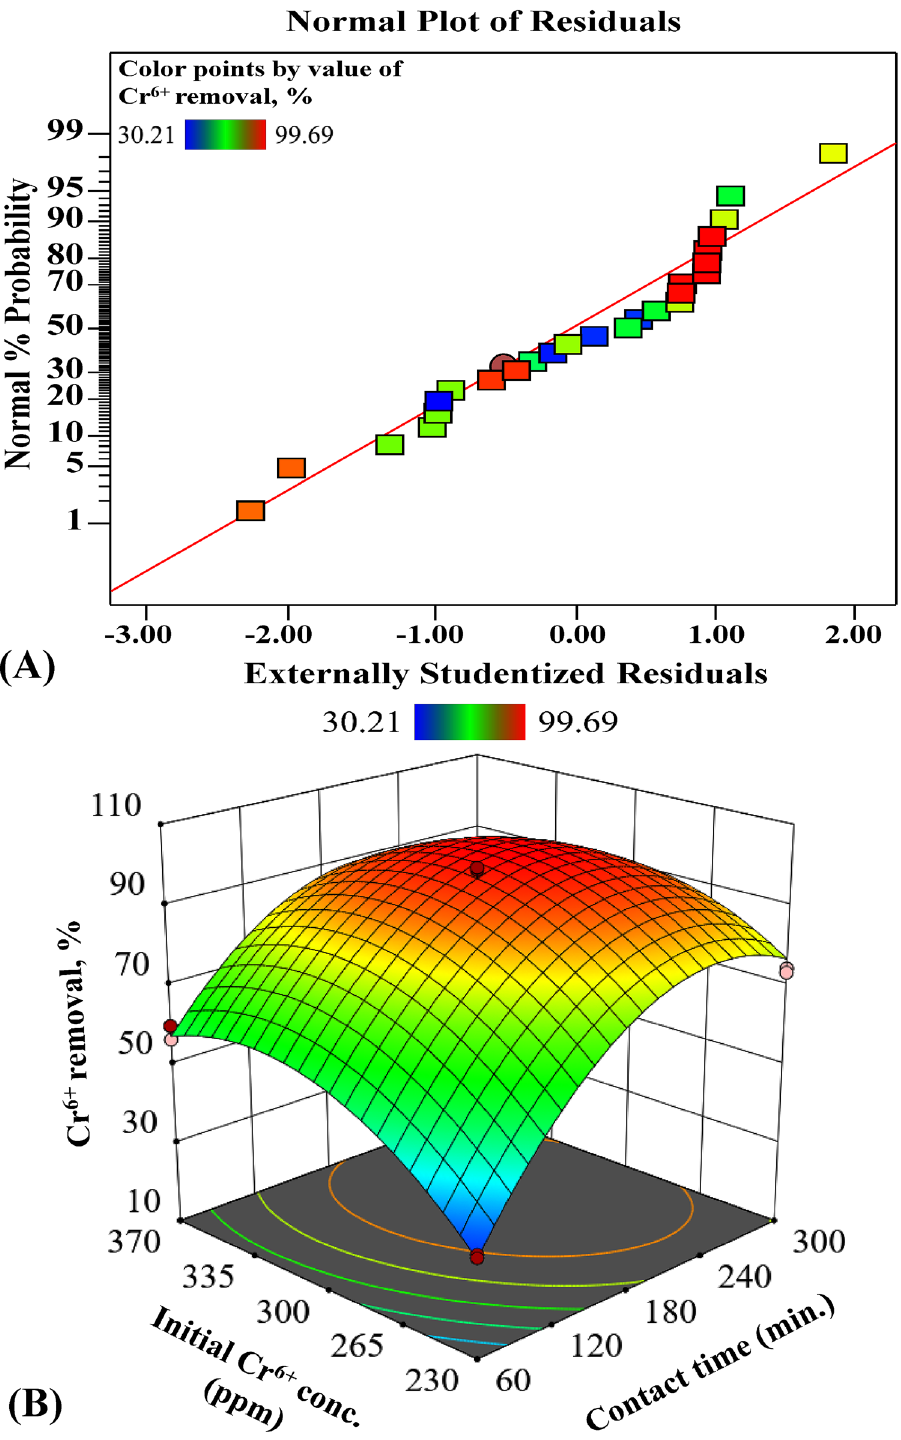
Figure 2. Normal probability plot of externally standardized residuals ( A ) and three-dimensional surface curve of Cr 6+ -removal as combined influence of contact time and initial Cr 6+ conc. by RCCD ( B ). This figure was created by using Design Expert version 12 for Windows